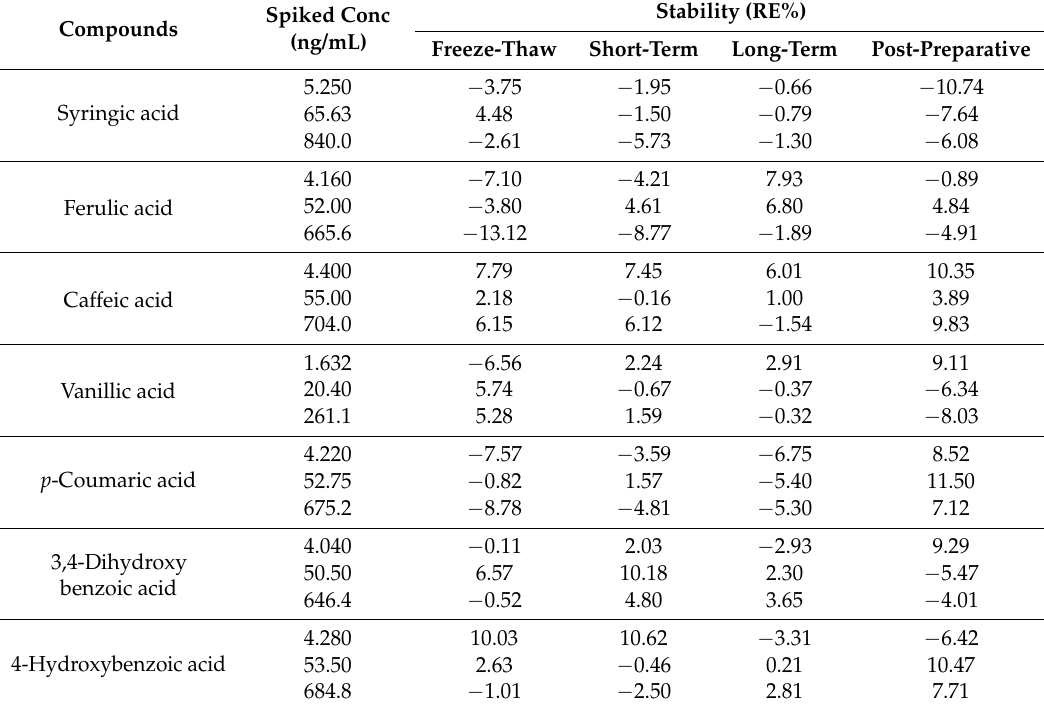
Table 3. The stability of the seven analytes under different storage conditions ( n =